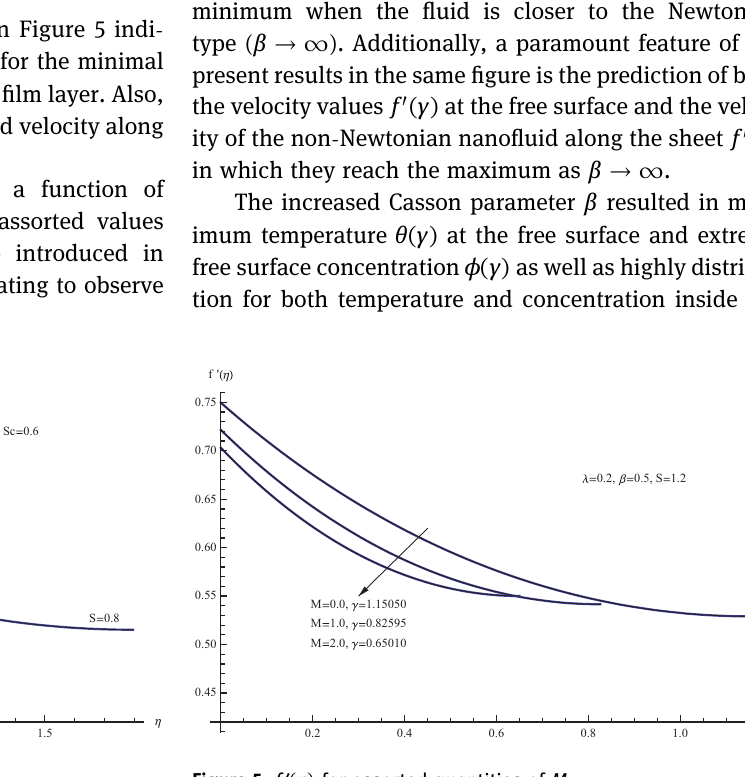
Figure 5: ( ) f η ′ for assorted quantities of M